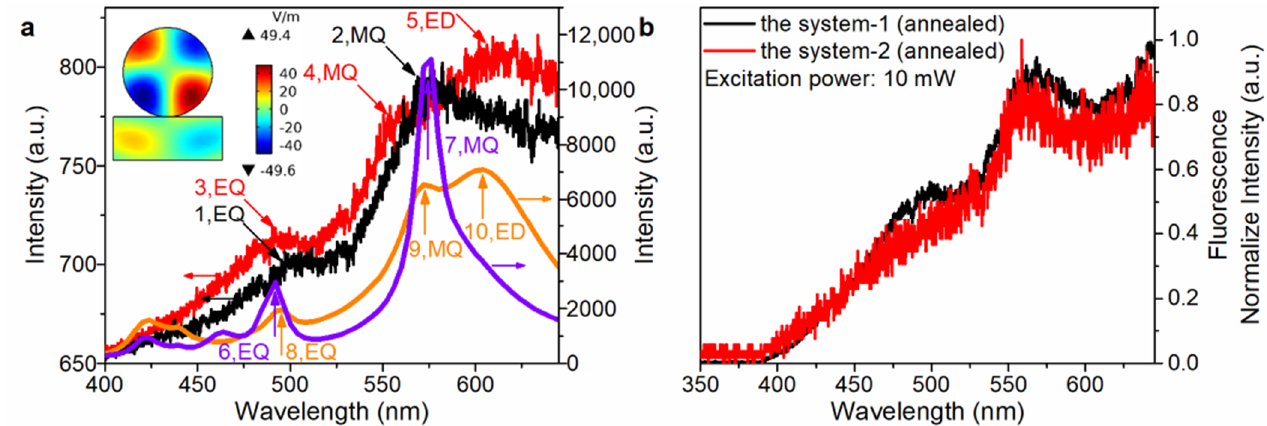
Figure 5. ( a ) The luminescence curves of Si NS on glass/Si substrates at an excitation wavelength of 777/775 nm and an excitation power of 5mW/14mW are shown as the black/red line; the simulated enhancement intensity curves of Si NS on glass/Si substrates are shown as the purple/orange; and the inset is the z component of electric filed in YZ plane at peak 10. ( b ) The comparison of normalized luminescence curves of the system-1/2 (annealed) at the same excitation power.